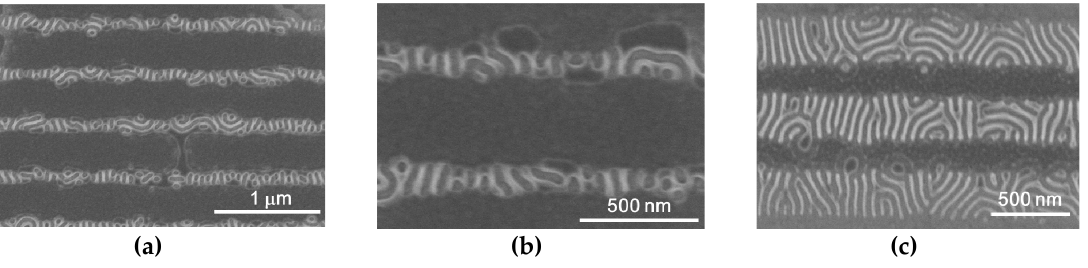
Figure 3. SEM micrographs of PMMA etched lamellar PS- b -PMMA block copolymer on Au deposited silicon substrates pre-coated with self-assembly monolayer (SAM). The widths of alternating stripes of SAMs were ( a ) 150 nm, ( b ) 150 nm and ( c ) 300 nm, respectively.